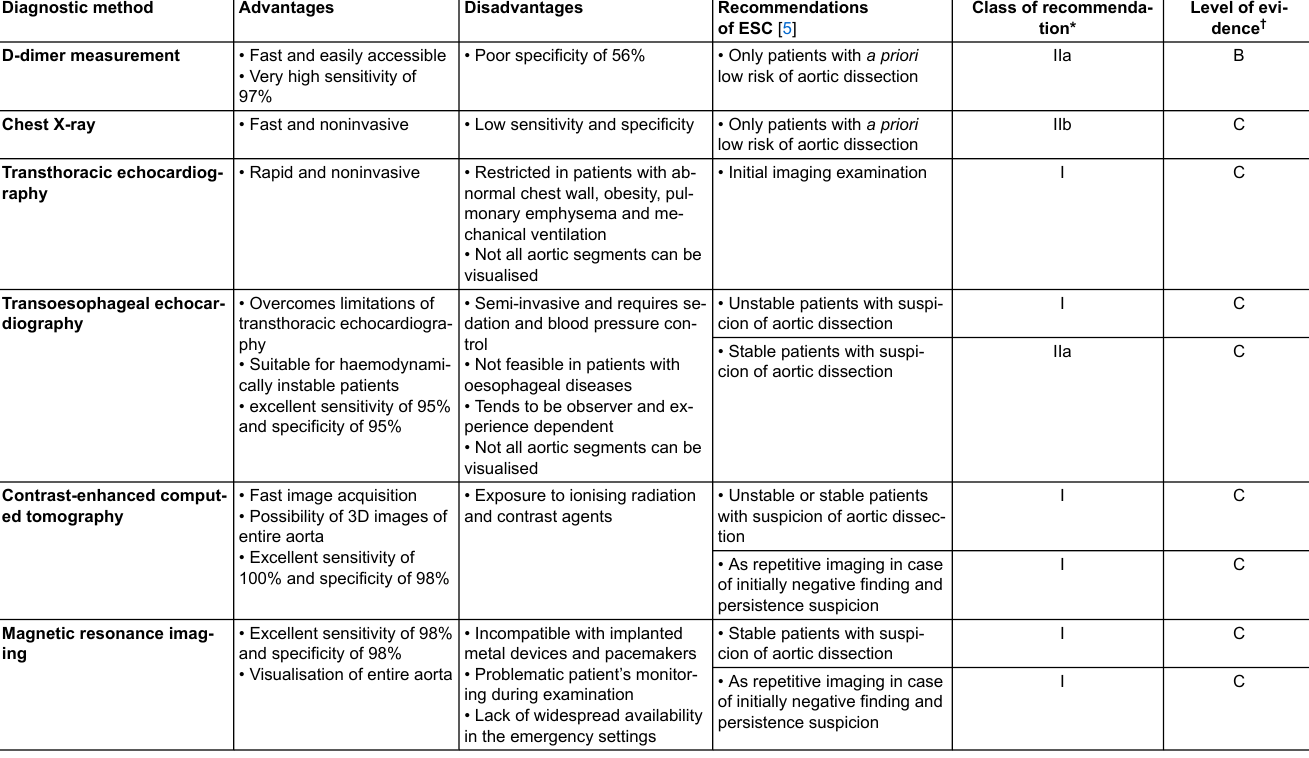
Table 2: Comparison of diagnostic methods in aortic dissection. Diagnostic